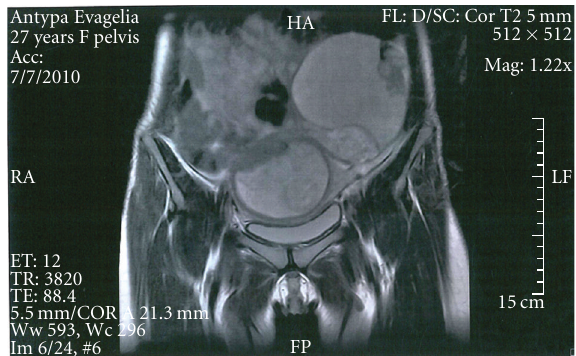
Figure 3: MRI of a mature cystic teratoma of the left ovary. A large cystic mass with component of high sigual intensity, consistent with